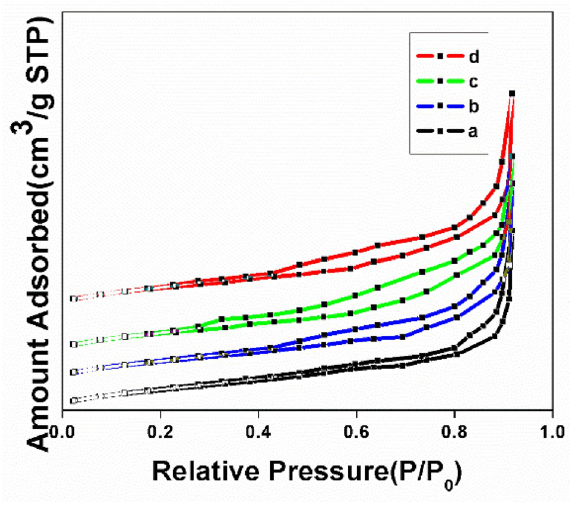
Figure 7. Nitrogen adsorption–desorption isotherm of ( a ) NT, ( b ) NT1, ( c ) NT2 and ( d ) NT3.